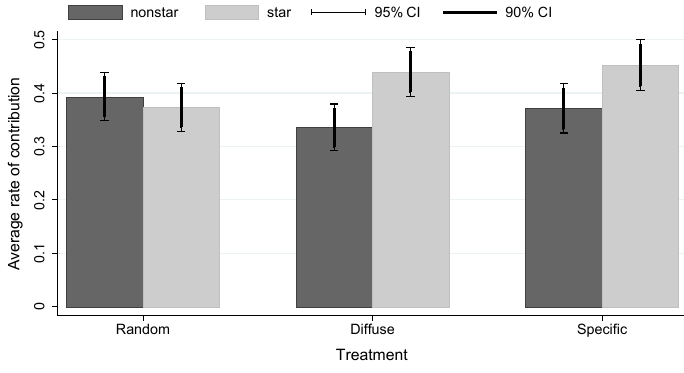
Figure 2: Mean rates of contribution by status group and